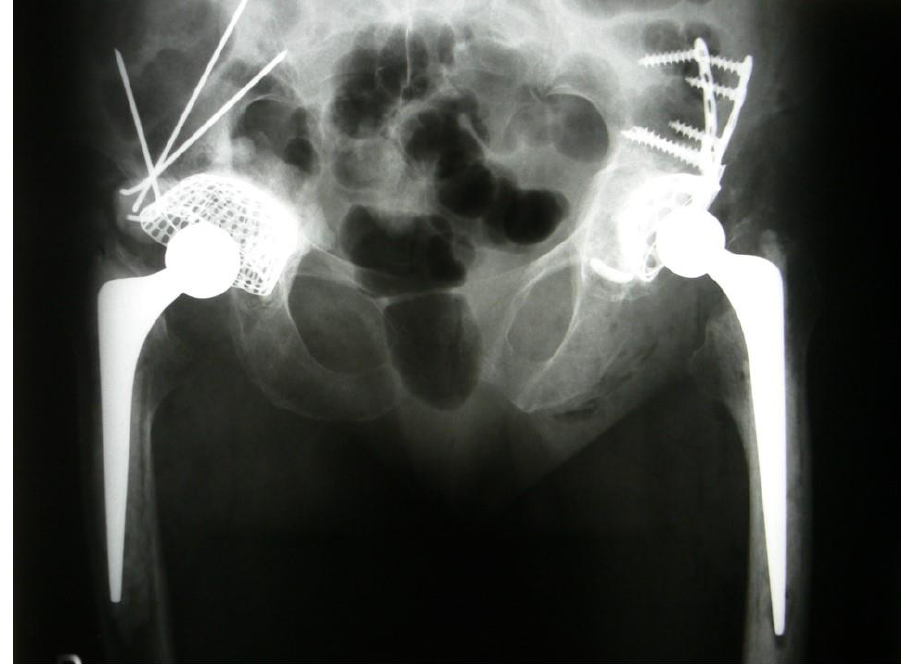
Figure 3. Status post revision arthroplasty of the right hip joint and primary arthroplasty of the left hip joint. An AP radiograph of the pelvis and the hip joints.